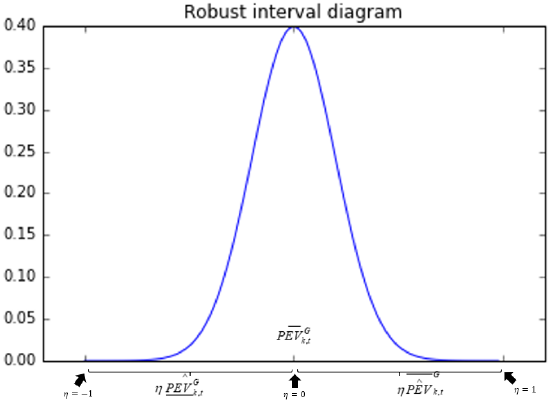
Figure 2 . Robust interval schematic. Figure 2. Robust interval